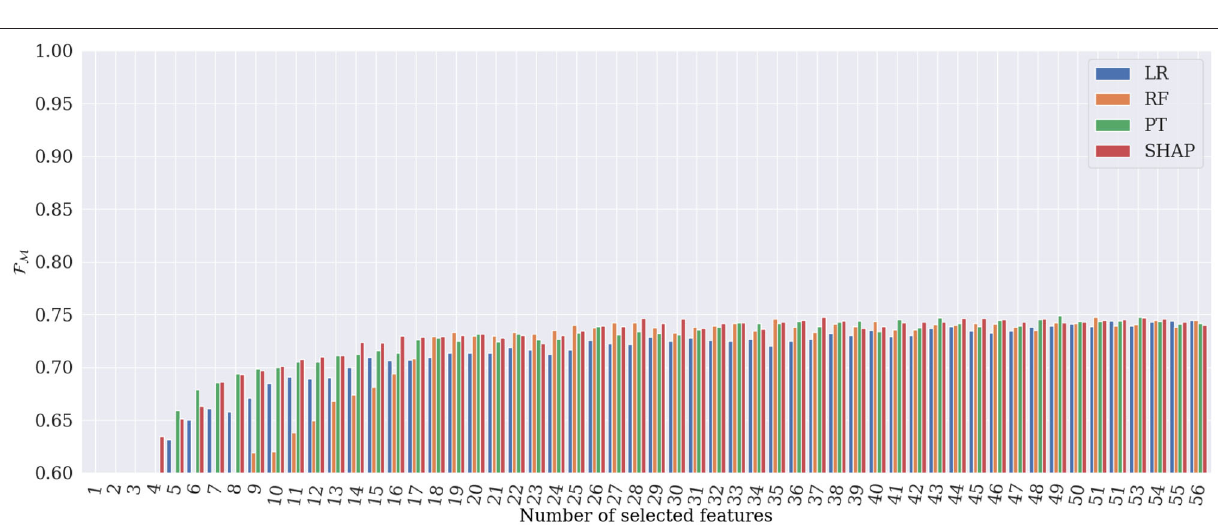
FIGURE 7 | Results of heart rhythm classification in terms of F M , by RF classifier applied to only the most important features. SHAP generates the best classification results based on only 28